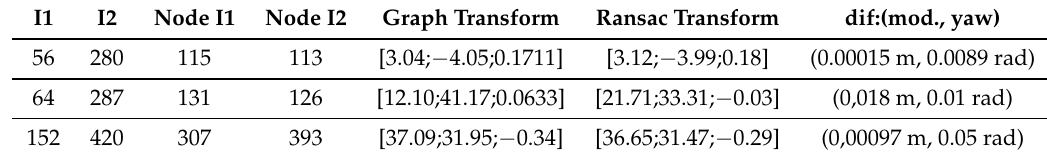
Table 1. Comparison of Transforms between images of S 11 and S 12.